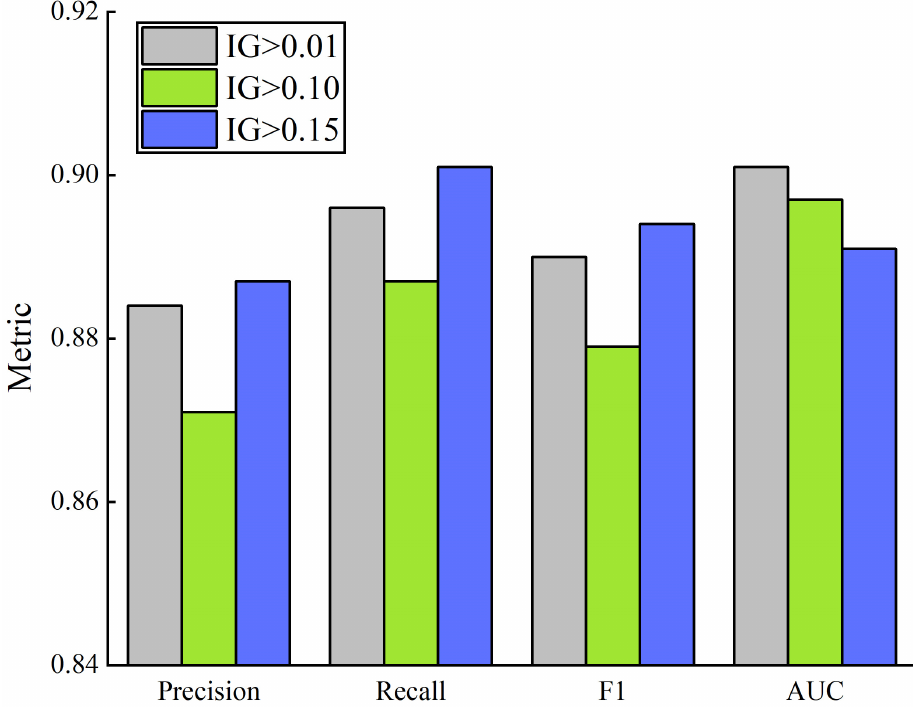
Figure 12. Comparison of models based on inputs with different IG indices.